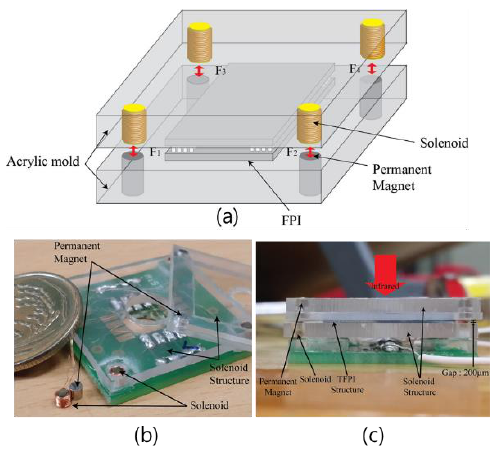
Figure 5. ( a ) Schematic, ( b ) top, and ( c ) cross-sectional view of the fabricated